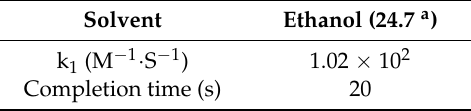
Table 1. Kinetic data for Step 1 of the reaction in ethanol as the solvent at 293.15